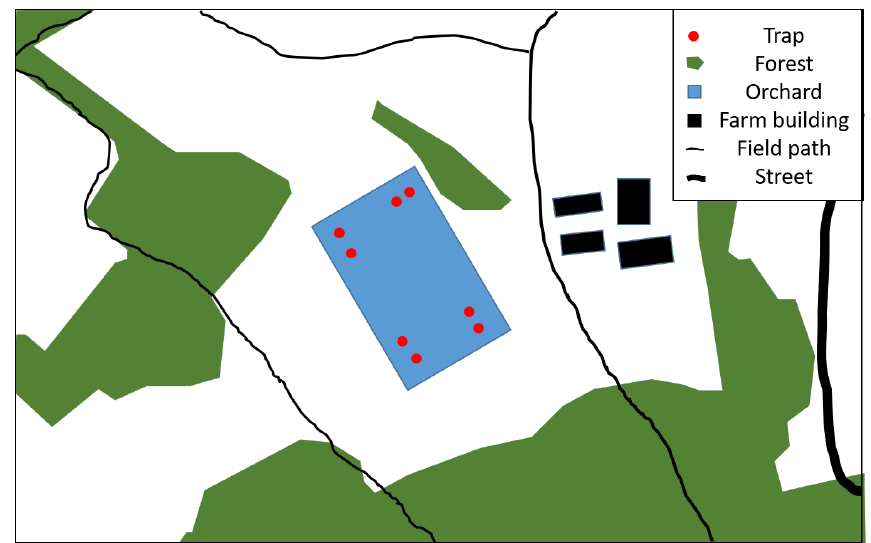
Figure A1. Drawing of the sweet cherry orchard, its surroundings and traps at Wölflinswil.